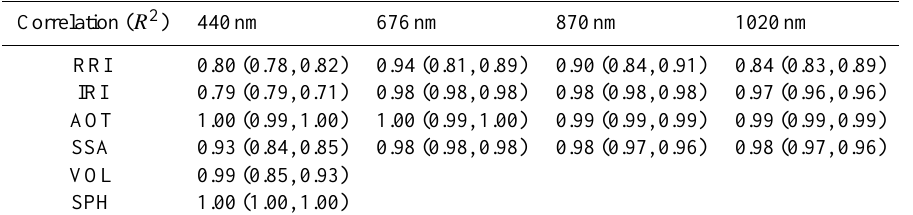
Table 5. Squared Pearson correlation coefficients ( R 2 ) between model computed (optimized) values and AERONET inversions of the real and imaginary part of the refractive index (RRI and IRI), aerosol optical thickness (AOT), single-scattering albedo (SSA) at four wavelengths, the sum of the binned AERONET volume distribution (VOL), AERONET spherical fraction (SPH) and columnar relative humidity (RH) derived from radiosonde measurements for the non-suspect data, L1.5 and L2 ∗ data (latter two between parentheses) during the first 14 days of May.